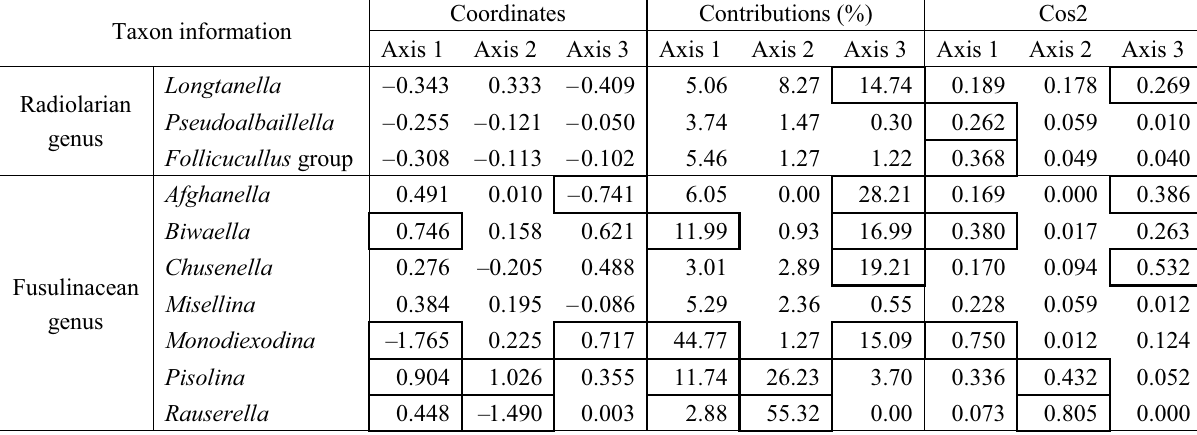
Table 3. Coordinates, contributions and Cos2 of the columns (genus) in the first three dimensions. Black box marks to bigger absolute values.